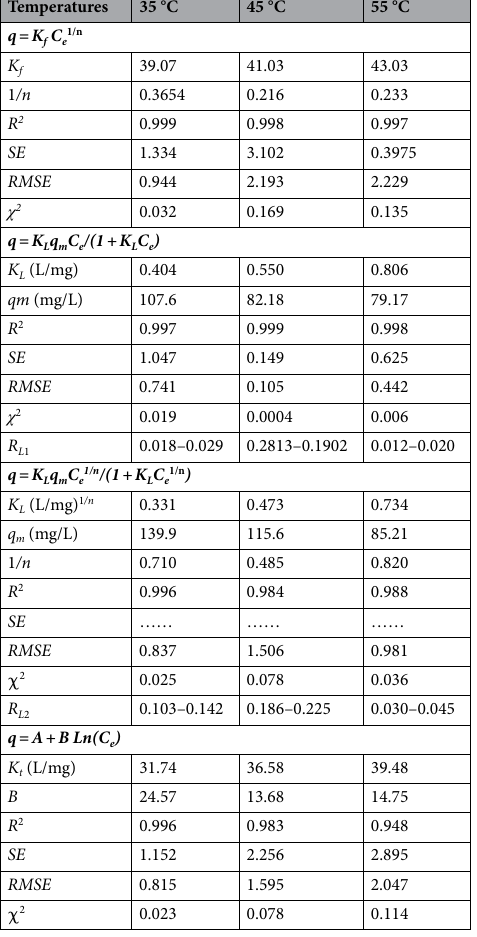
Table 4. Estimated isotherm parameters for MB adsorption on Cu(OH) 2 -NWs-PVA-AC Nano composite at different